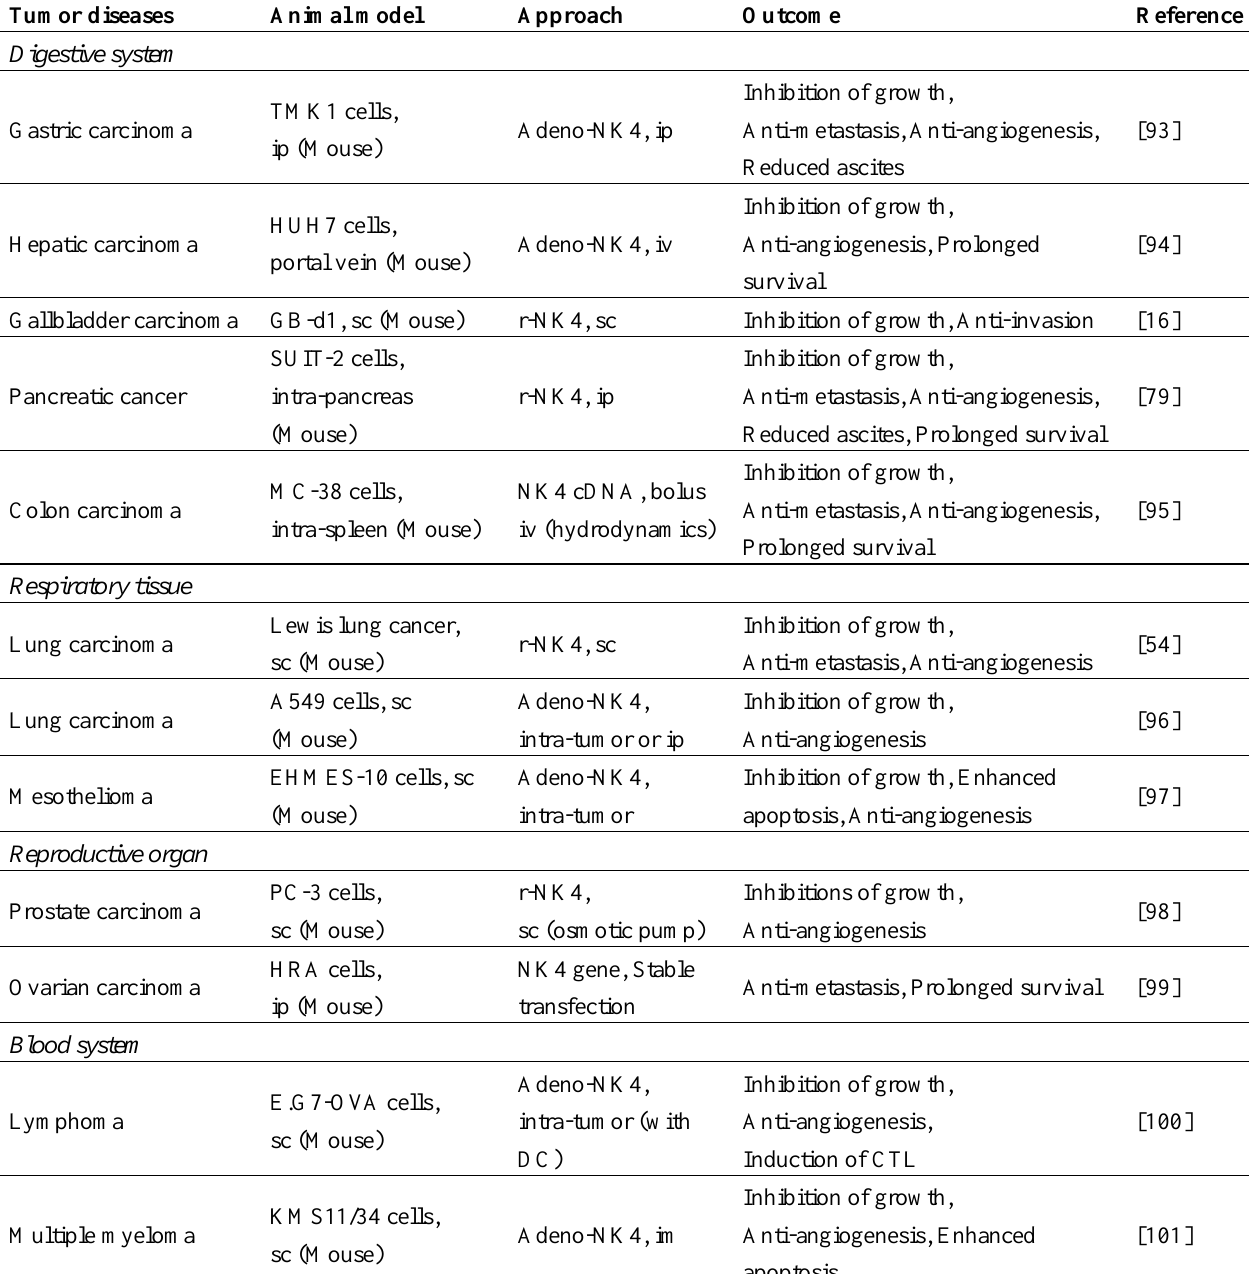
Table 2. Representative studies to show beneficial effects of NK4 on distinct types